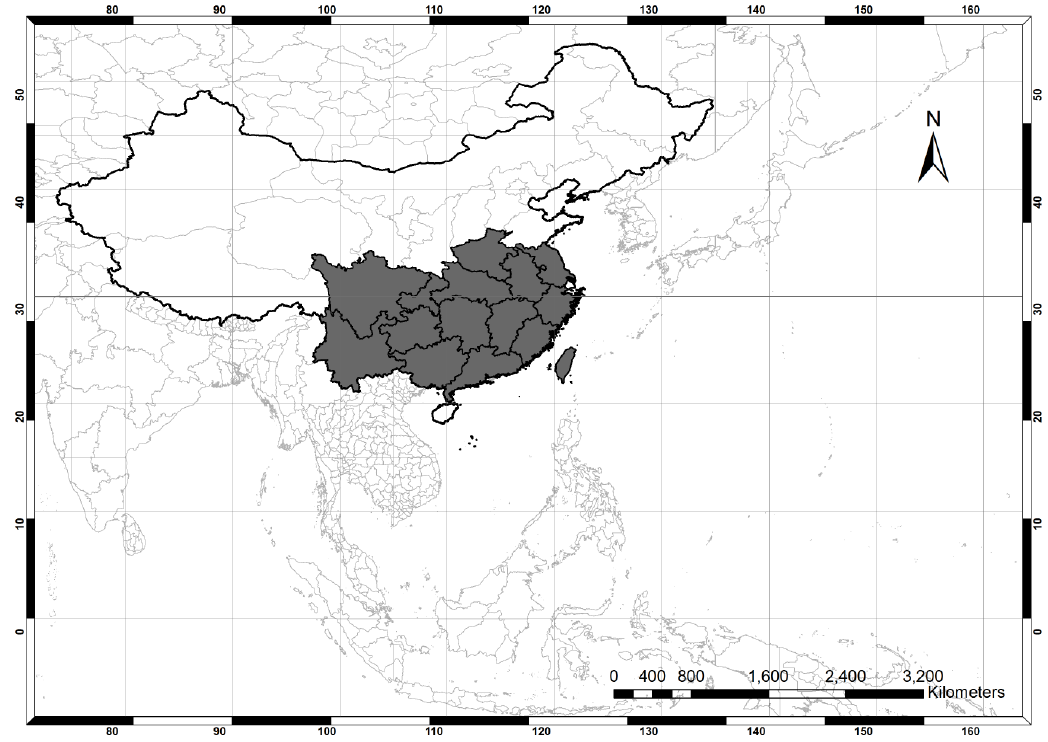
Figure 1. Study area—Provinces with present natural distribution of Chinese